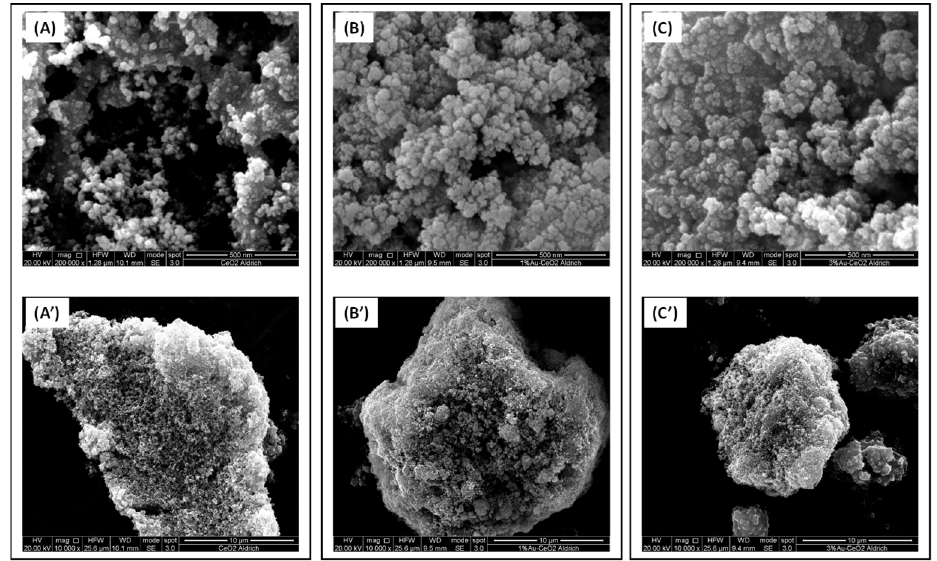
Figure 4. SEM micrographs of the prepared powders at two different magnifications for ( A , A ′ ) bare CeO 2 A; ( B , B ′ ) 1%Au/CeO 2 A and ( C , C ′ ) 3%Au/CeO 2 A.